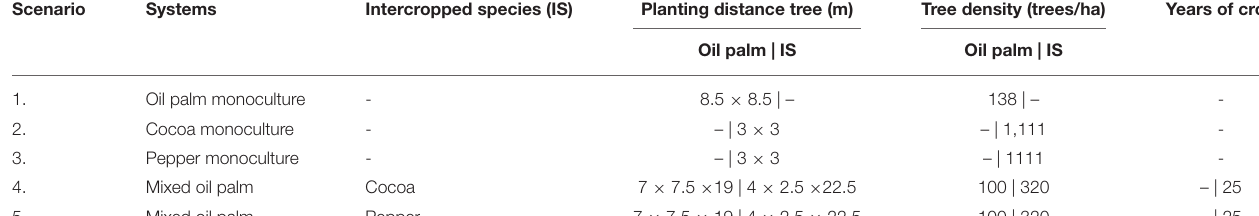
TABLE 4 | The simulated diversification scenarios with details on intercrop species, planting density, and years of intercropping.